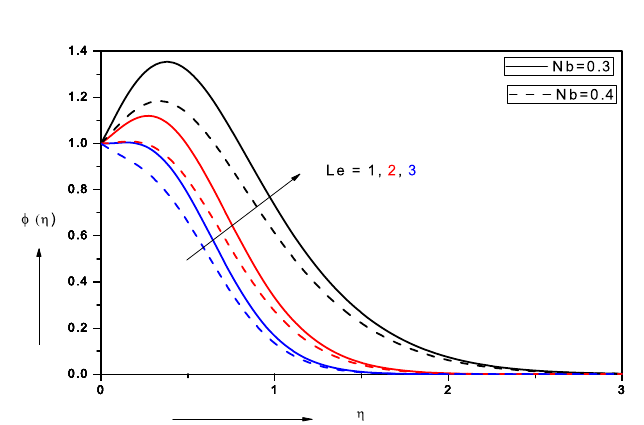
Figure 9. Effect of Lewis number ( Le ) on nanofluid volume fraction.